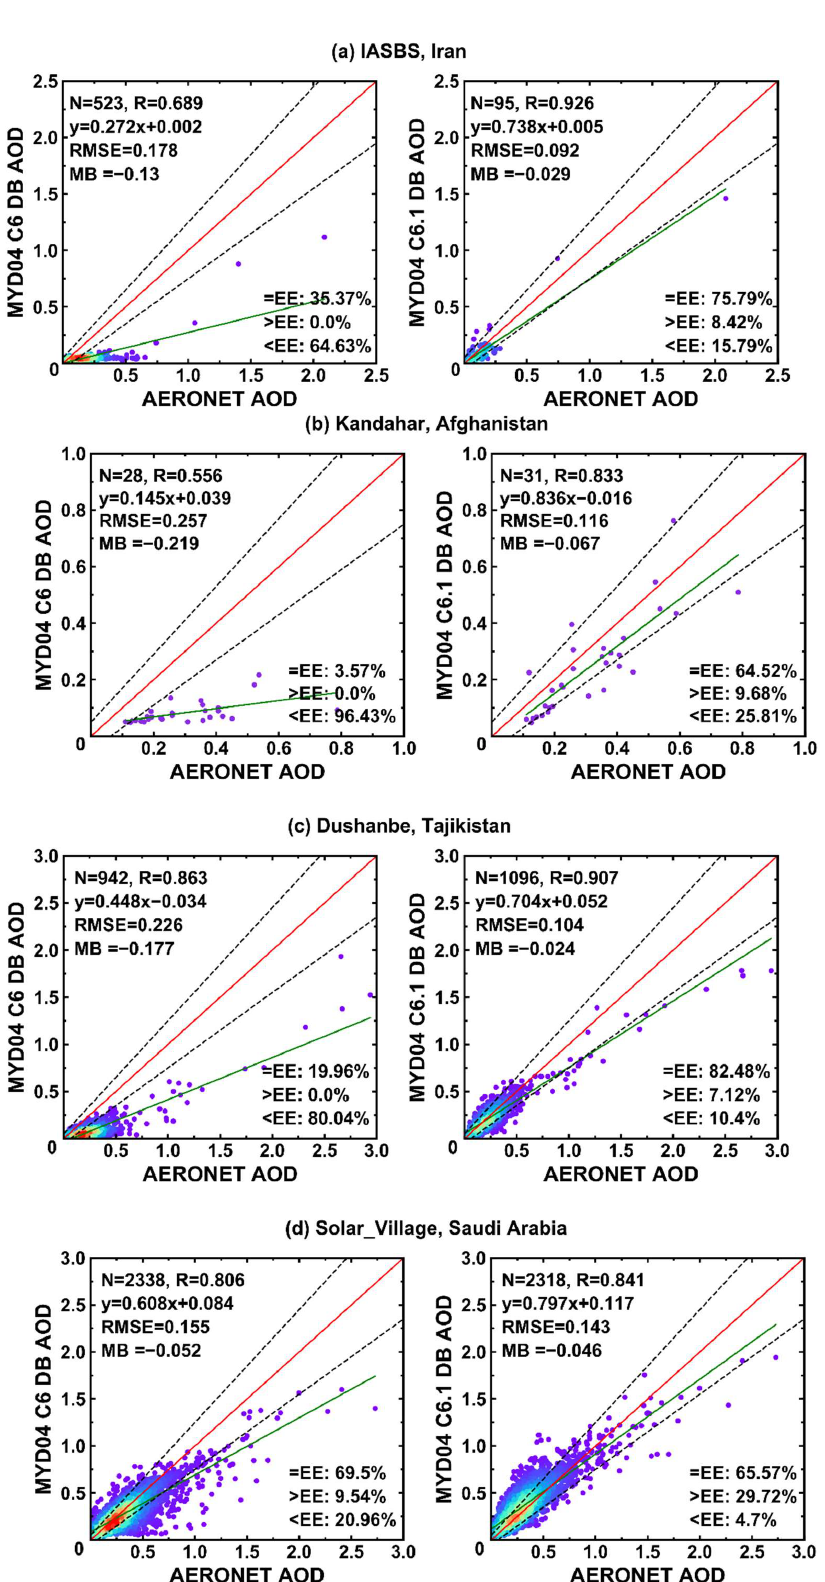
Figure 2. Validation of Aqua MODIS C6 ( left ) and C6.1 ( right ) Deep Blue 10 km AOD against AERONET AOD at IASBS, Kandahar, Dushanbe and Solar_Village. One-one line, linear regression line, and the expected error (EE) envelopes of ±(0.05 + 20%AOD AERONET ) are plotted as green solid, red solid, and black dashed lines. ( a ) IASBS, Iran; ( b ) Kandahar, Afghanistan; ( c ) Dushanbe, Tajikistan; ( d ) Solar_Village, Saudi Arabia. For the sites of IASBS in Iran and Kandahar in Afghanistan, a nearly constant value of around 0.05 was found in the scatter plots of C6 products. Both sites exhibit a serious underestimation with a large fraction of 64.63% and 96.43% collections falling below EE and with large negative MB of −0.13 and −0.219, respectively. Furthermore, a poor correlation can be seen with a low R of 0.689 and 0.556 between DB and AERONET AOD, and with only 35.37% and 3.57% falling within EE, respectively. However, the accuracy of